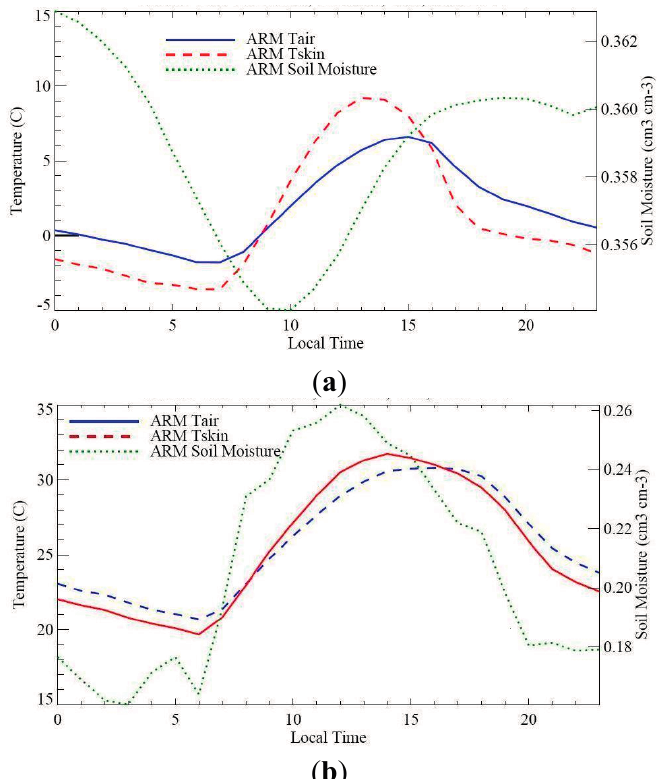
Figure 1. Monthly mean diurnal cycle of skin temperature (Tskin), upper-layer soil moisture, and 2-m air temperature (Tair) for ( a ) January 2004; ( b ) July 2004. Data is from Atmospheric Radiation Measurement (ARM) Lamont, OK